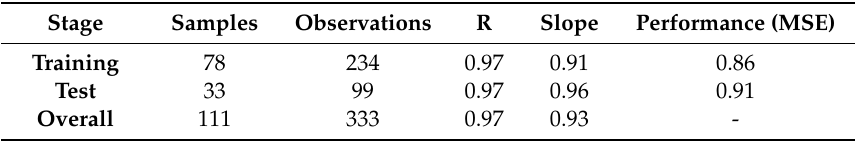
Table 4. Regression model using machine learning (Sequential Order Weights and Bias) for NIR data from berries of seven grapevine cultivars showing the correlation coefficient (R) and performance based on mean squared error (MSE) for each stage.